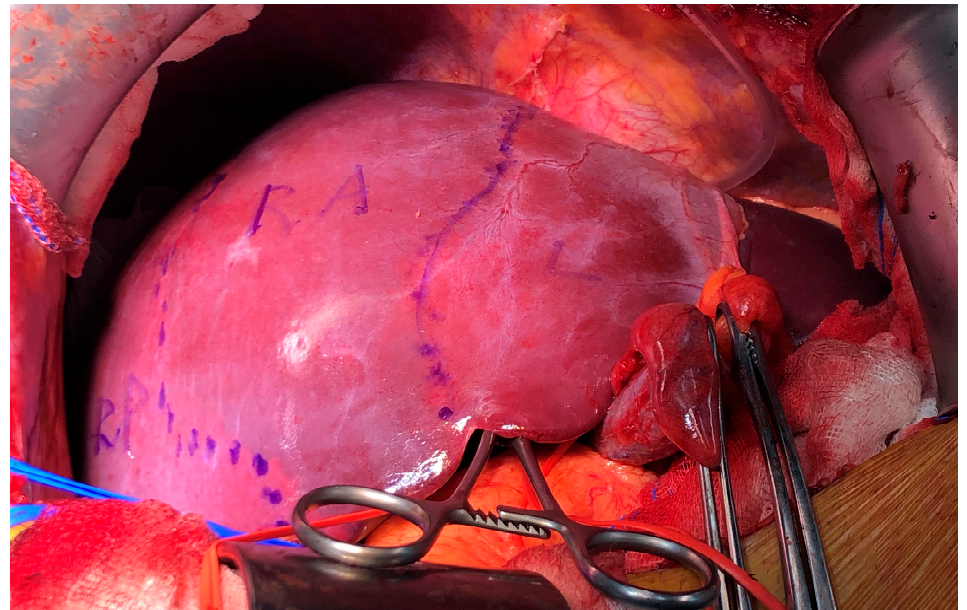
Figure 2. Intraoperative photo of right anterior section demarcation after clamping right anterior pedicle for anatomic resection of a tumor occupying both segment 5 and segment 8 of the liver. RA, right anterior section; RP, right posterior section; L, left hemiliver.